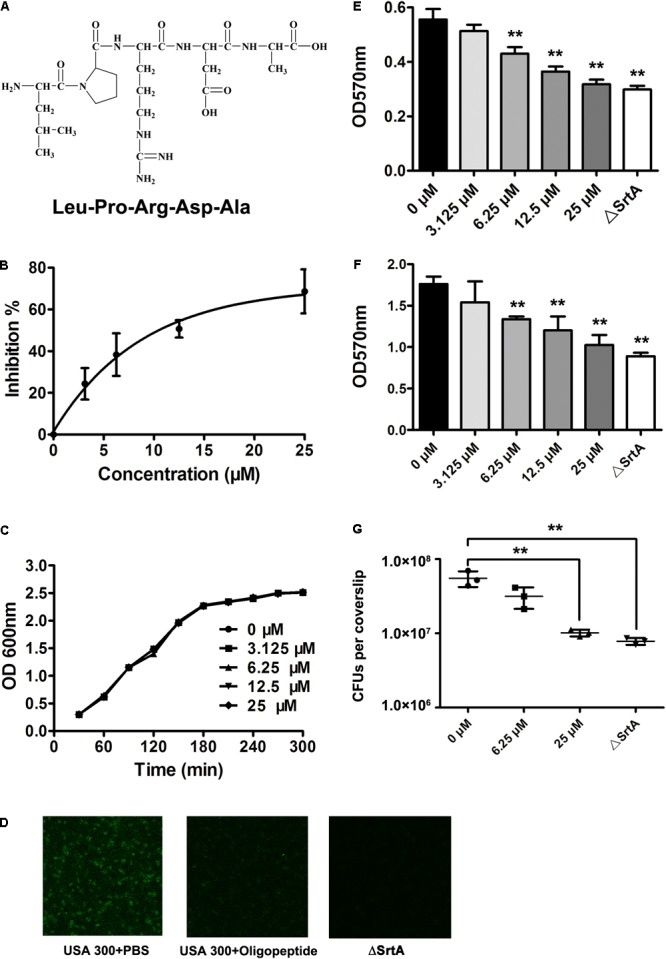
Inhibition of SrtA activity both in vitro and in vivo by the oligopeptide. (A) The molecular structure of the oligopeptide, LPRDA. (B) The inhibitory effect of the oligopeptide on SrtA activity. The fluorescent peptide substrate Dabcyl-QALPTTGEE-Edans was mixed with purified SrtA preincubated with various concentrations of the oligopeptide, and the fluorescence intensity of the reaction system was determined at emission and excitation wavelengths of 350 and 520 nm, respectively (n = 3). (C) The growth of S. aureus USA 300 cultured in TSB in the presence of increasing concentrations of the oligopeptide was monitored by measuring the OD at 600 nm every 60 min. Oligopeptide treatment inhibits the binding of S. aureus to fibronectin (D) and the formation of S. aureus biofilm (E) (n = 3) (∗p < 0.05, ∗∗p < 0.01). (F) Inhibition of S. aureus invasion into J774 cells by the oligopeptide. J774 cells were infected with S. aureus at 37°C for 1 h, and the total colony-forming units (CFU) for lysed cells was evaluated (n = 3) (∗p < 0.05, ∗∗p < 0.01). (G) The presence of protein A on the cell envelopes of S. aureus treated with or without the oligopeptide and its SrtA mutant was viewed under a confocal laser scanning microscope following staining with an FITC-conjugated antibody. Results are reported as mean ± SEM.